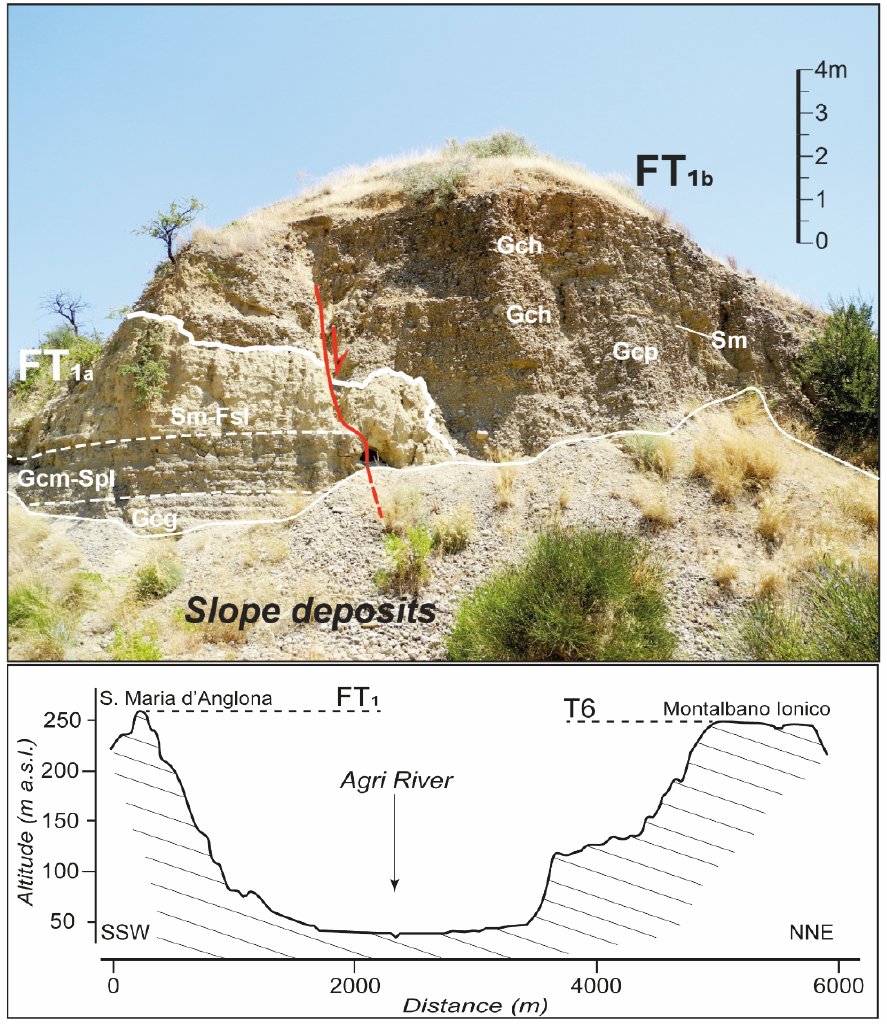
Figure 5. The photo shows both the FT 1a and FT 1b sedimentary sequences of the S. Maria d’Anglona unit separated by a minor internal discontinuity (coarse white line). White dashed line divides the two lithofacies. Red line marks the synsedimentary normal fault. See Table 1 for facies code and interpretation. The topographical cross-profile in the box below shows the altimetrical correspondence of the FT 1 fluvial terrace and the T6 marine terrace.